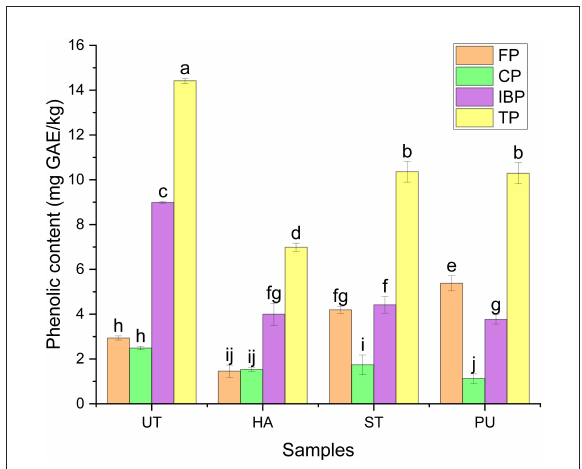
FIGURE7 The contents of different forms of phenolics of camellia oil from untreated and HA, ST, PU pretreated camellia seeds. Bars with no letter in common are significant different ( P < 0.05).